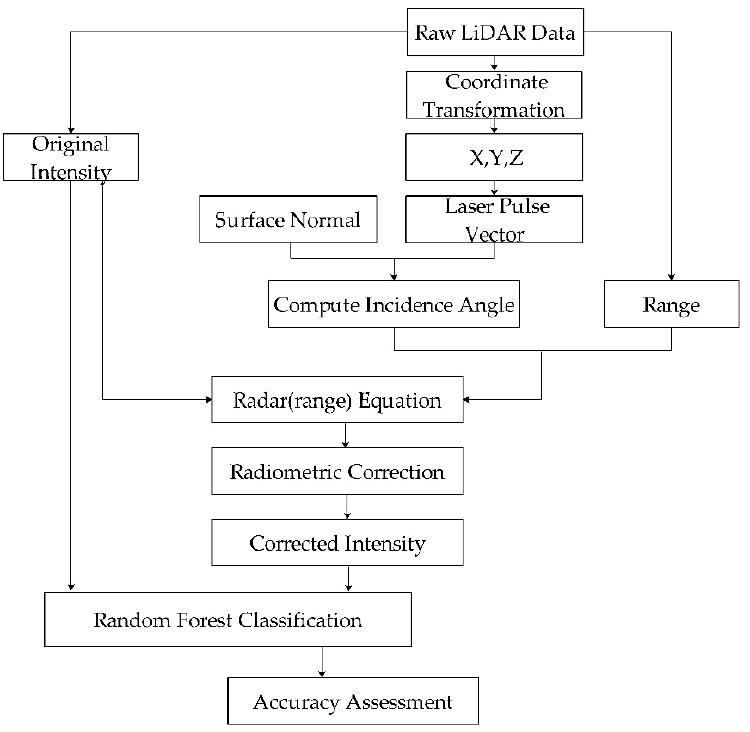
Figure 2. The workflow for radiometric correction of LiDAR data and accuracy assessment.